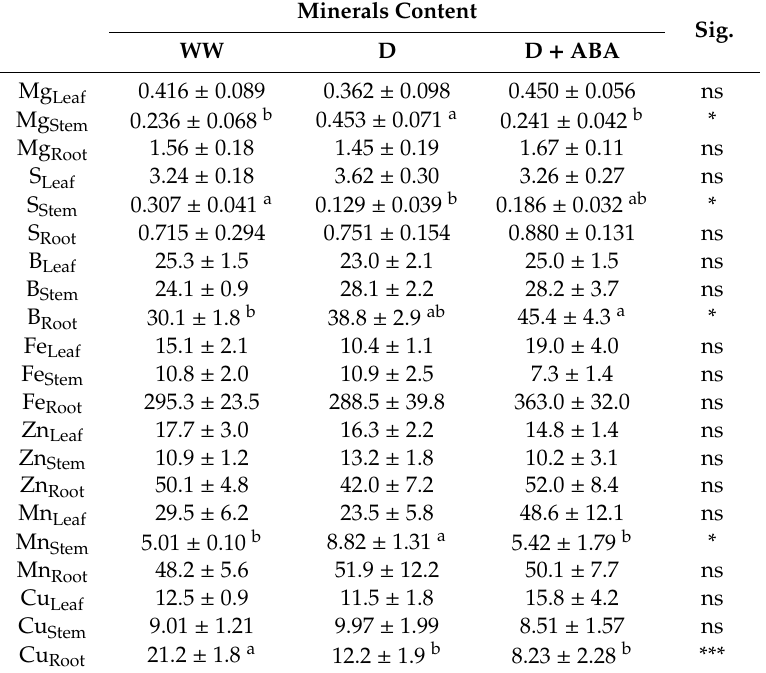
Minerals Content